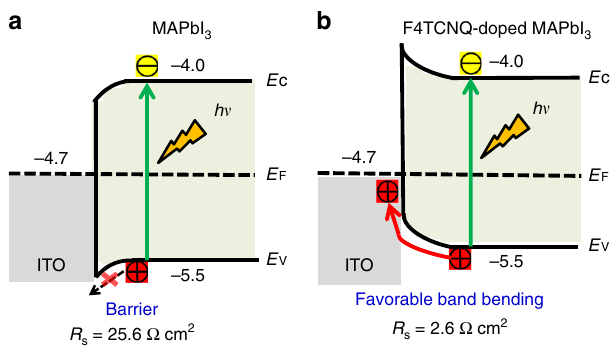
Fig. 4 Interfacial hole transfer dynamics. Schematic illustrations of hole transfer at the a ITO/MAPbI 3 or b ITO/F4TCNQ-doped MAPbI 3